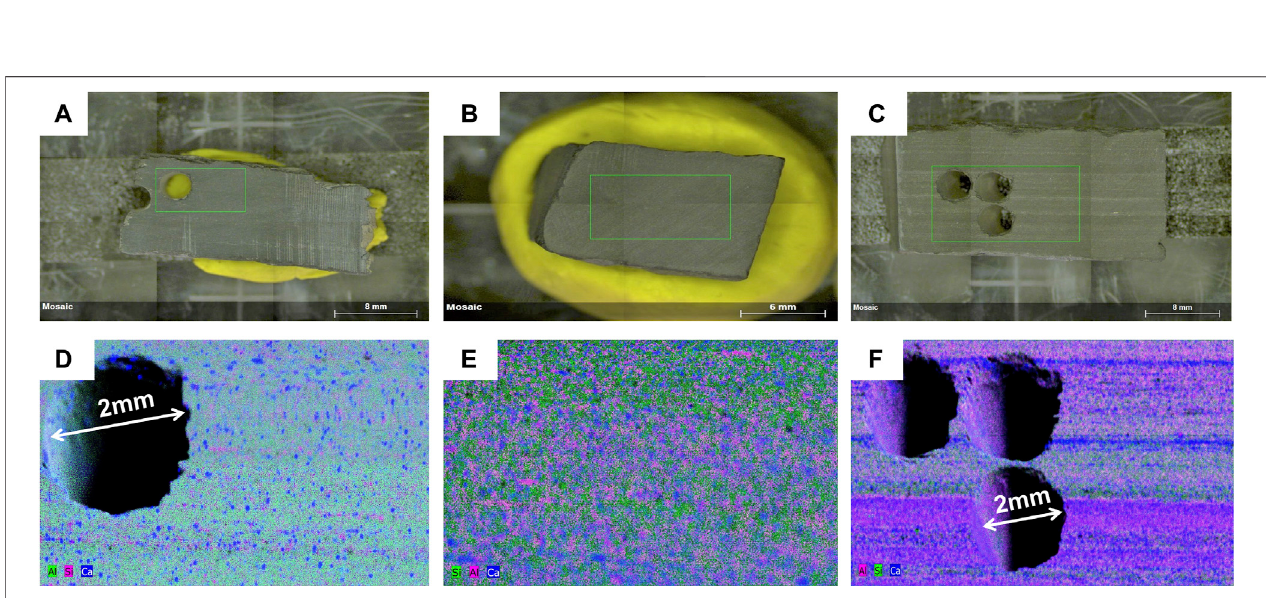
FIGURE 3 | XRF images of the three shale samples investigated, showing fi ne sedimentary structures and predominant mineral (elemental) compositions. (A,D) , Sample Sw-1; (B,E) , Sample JY9; (C,F) , Sample WY23-6-6.